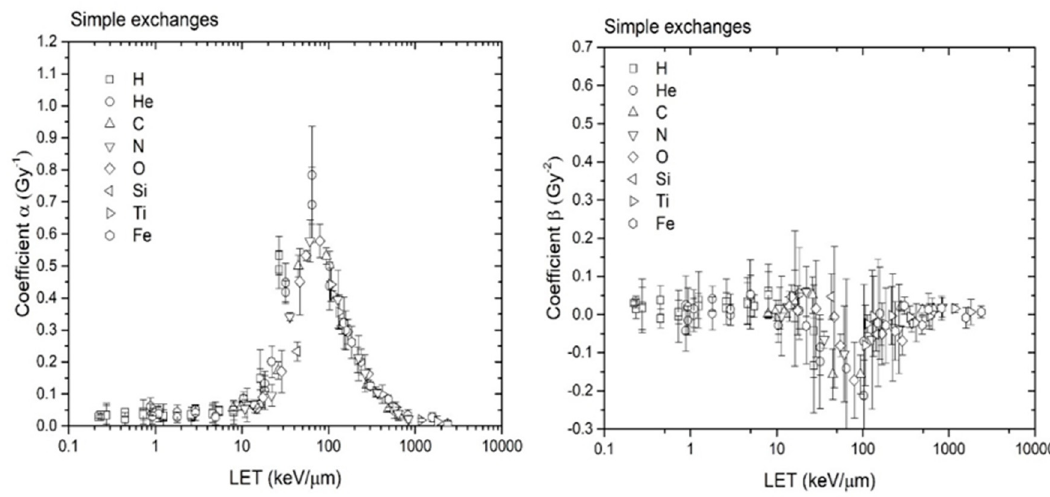
Figure 9. Coefficients α and β of the linear-quadratic model for simple exchanges plotted as a function of the LET.